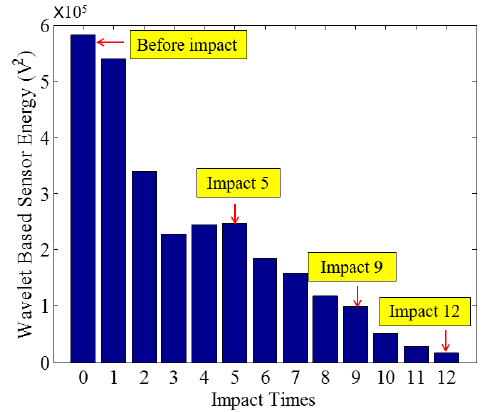
Figure 12. Wavelet packet-based energy plots of the received signal in PVA-ECC 1 .